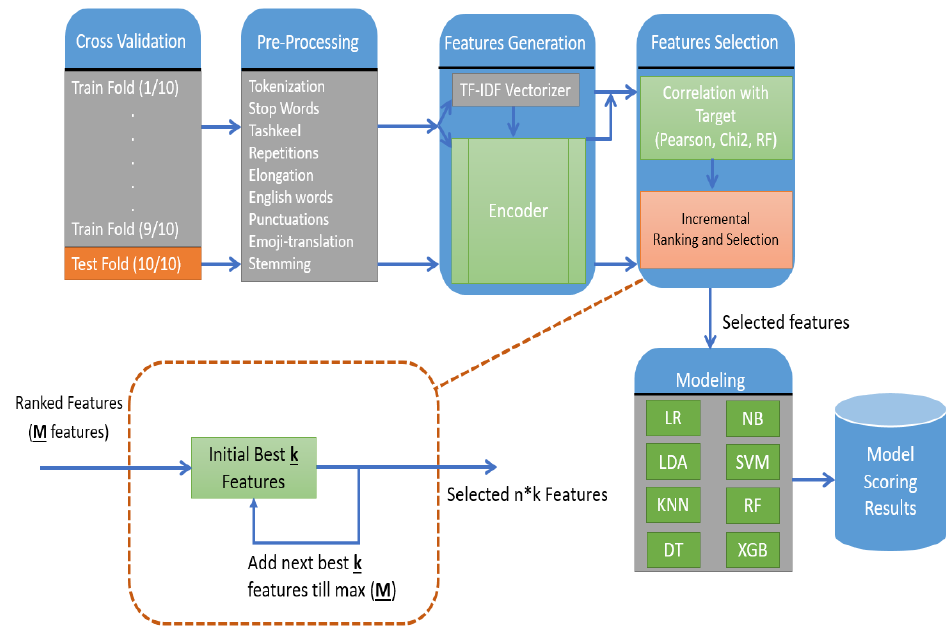
Figure 2. Proposed methodology of multi-stage feature generation and selection mechanism .